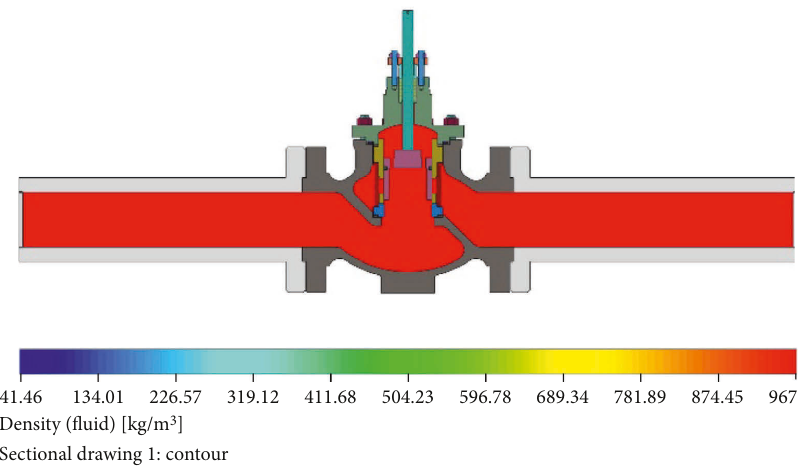
Figure 24: Fluid density cloud for 20% opening.